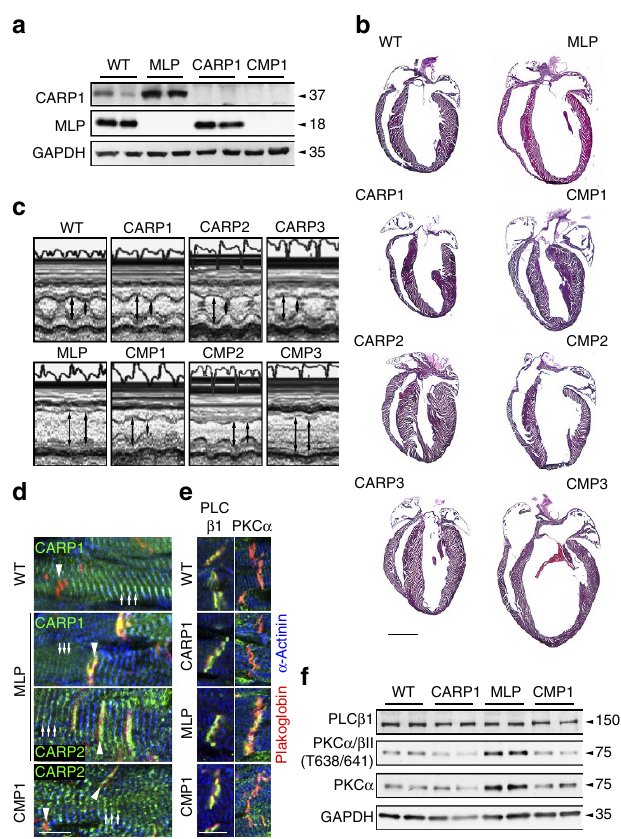
Figure 4 | DCM in MLP knockout mice is prevented in the absence of CARP1 or CARP2. ( a ) Expression levels of CARP1, MLP and GAPDH as control in total heart extracts of WT, MLP knockout, CARP1 knockout and CARP1-MLP double knockout (CMP1) mice. ( b ) Cardiac morphology of WT, MLP, CARP1, CARP2 or CARP3 knockouts, as well as CARP1-MLP (CMP1), CARP2-MLP (CMP2) and CARP3-MLP (CMP3) double knockouts. Hematoxylin-eosin stained frozen heart sections are shown. Scale bar ¼ 2mm. ( c ) Analysis of cardiac function using M-mode transthoracic echocardiography and representative M-mode images of hearts from WT, MLP, CARP1, CMP1, CARP2, CMP2, CARP3 and CMP3 animals. ( d ) Immunofluorescence staining of frozen heart sections from adult WT, MLP knockout and CMP1 double knockout animals stained with antibodies against CARP1 (green in overlay, top two panels) and CARP2 (green in overlay, bottom two panels). Arrowheads indicate ID and arrows show Z-disc localization, respectively. ( e ) Frozen sections of adult WT, CARP1, MLP knockout and CMP1 hearts stained with antibodies against PLC b 1 and PKC a (all green; see Supplementary Fig. 2h,i for quantification of PKC a localization at ID). ( d , e ) Plakoglobin and a -actinin were used as counterstains (red and blue in overlay, respectively). Scale bars ¼ 10 m m. ( f ) Immunoblot for PLC b 1, phospho-PKC a / b II (T638/641), and PKC a in WT, CARP1 knockout, MLP knockout and CMP1 double knockout total heart extracts. GAPDH was used as a loading